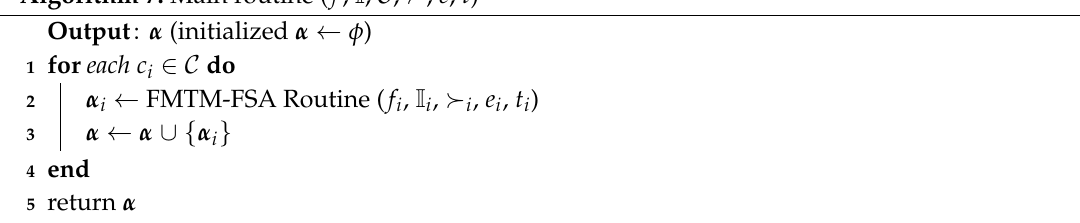
Algorithm 7: Main routine ( f , I ,